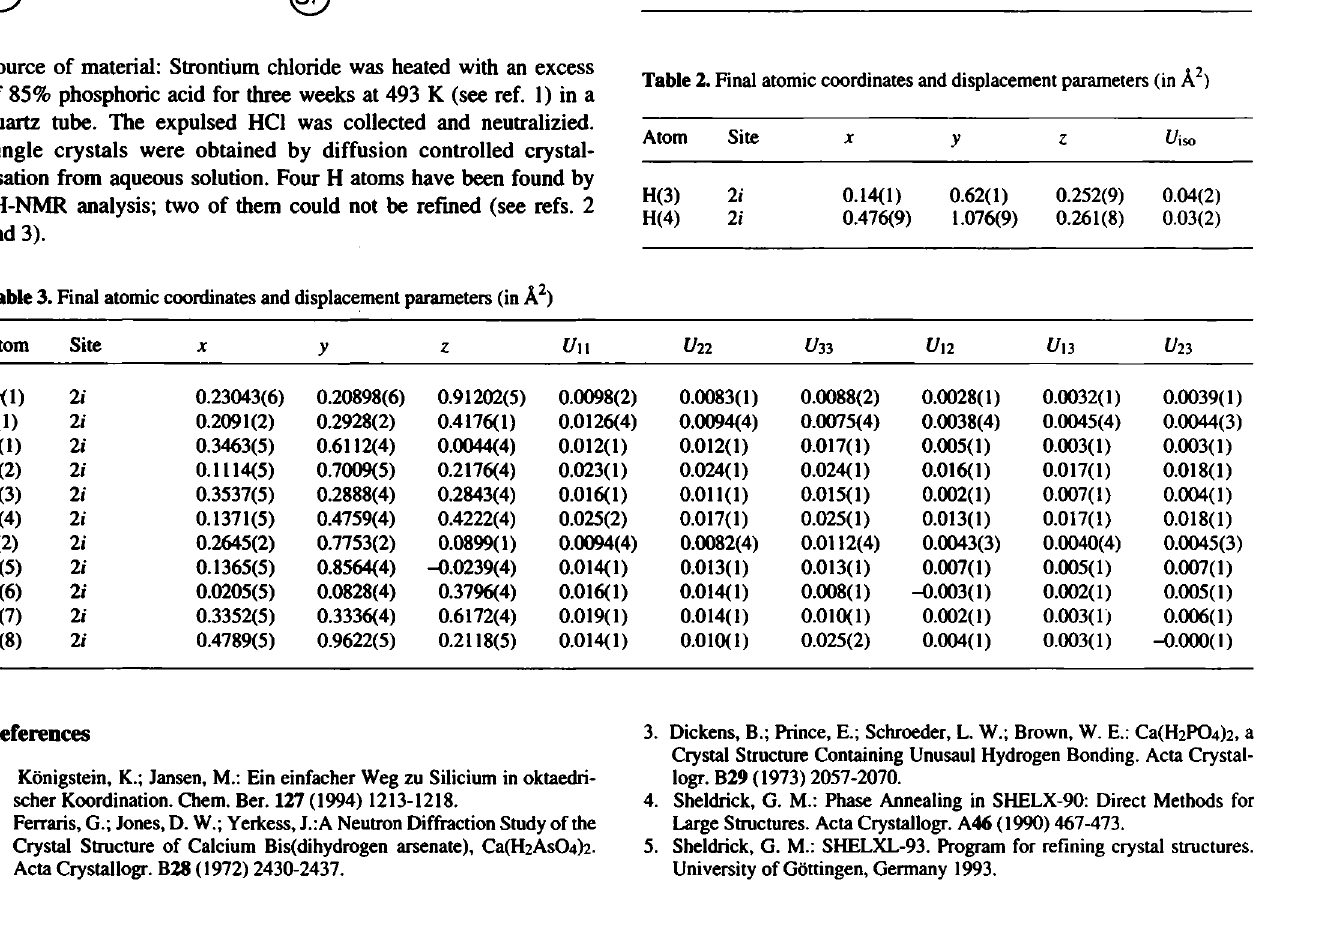
Table 1. Parameters used for the X-ray data collection Crystal: